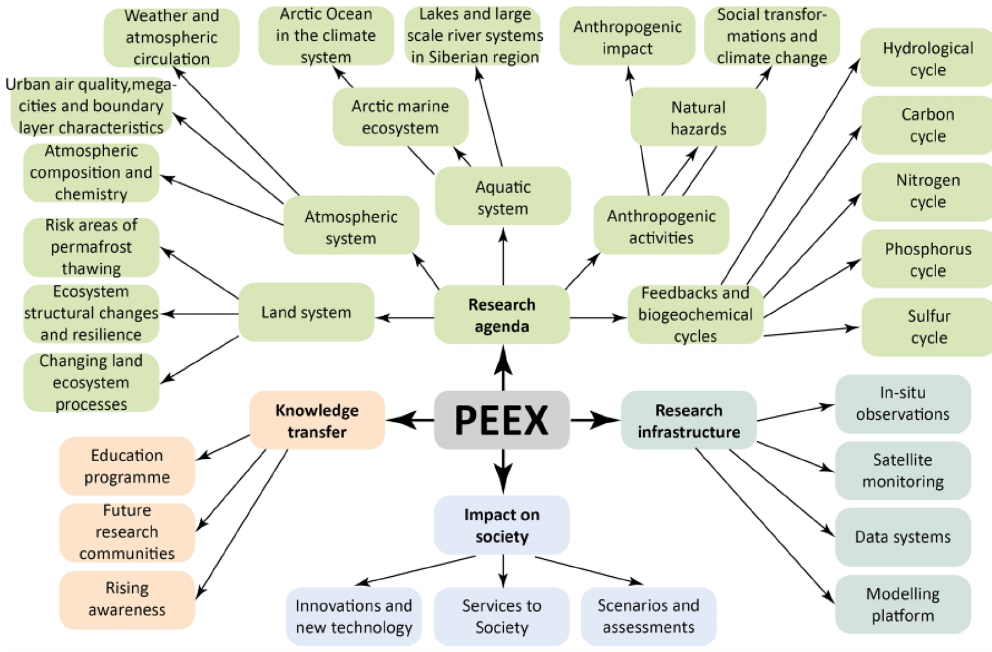
Figure 3. Schematic figure of the PEEX